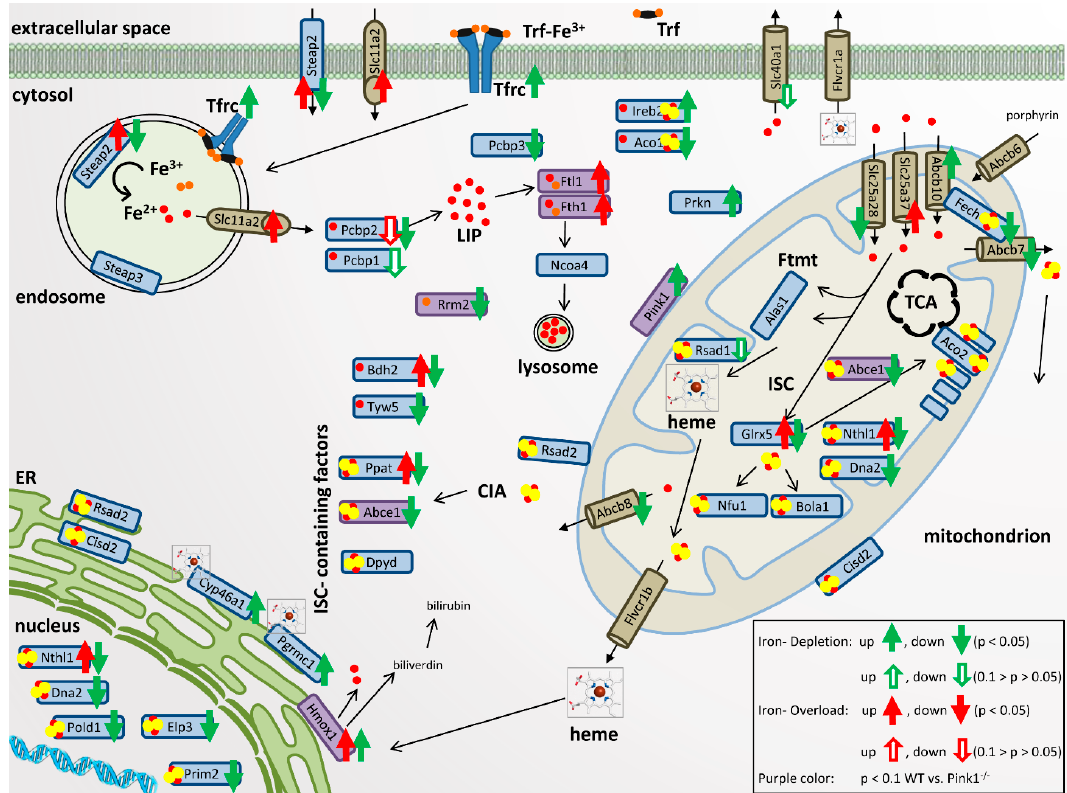
Figure 4. Overview of cellular iron uptake, storage, and export, iron transport and processing, mitochondrial iron homeostasis, heme production and turnover, iron-sulfur-cluster (ISC)-biogenesis and ISC-binding within the cells. For each factor with significant mRNA expression adaptation in room temperature (RT)-qPCR, green arrows indicate the direction of transcript change during iron depletion, while red arrows refer to changes during iron overload. Ferric iron (Fe3 + ) is illustrated with orange dots and ferrous iron (Fe2 + ) with red dots; ISC are represented by red and yellow dot clusters. CIA: cytosolic iron-sulfur-cluster assembly machinery; ER: endoplasmic reticulum; FTMT: mitochondrial ferritin; LIP: labile iron pool; TCA: tricarboxylic acid cycle. Factors with significant genotype-dependent changes with specificity for Pink1 − / − cells are represented by purple coloring.